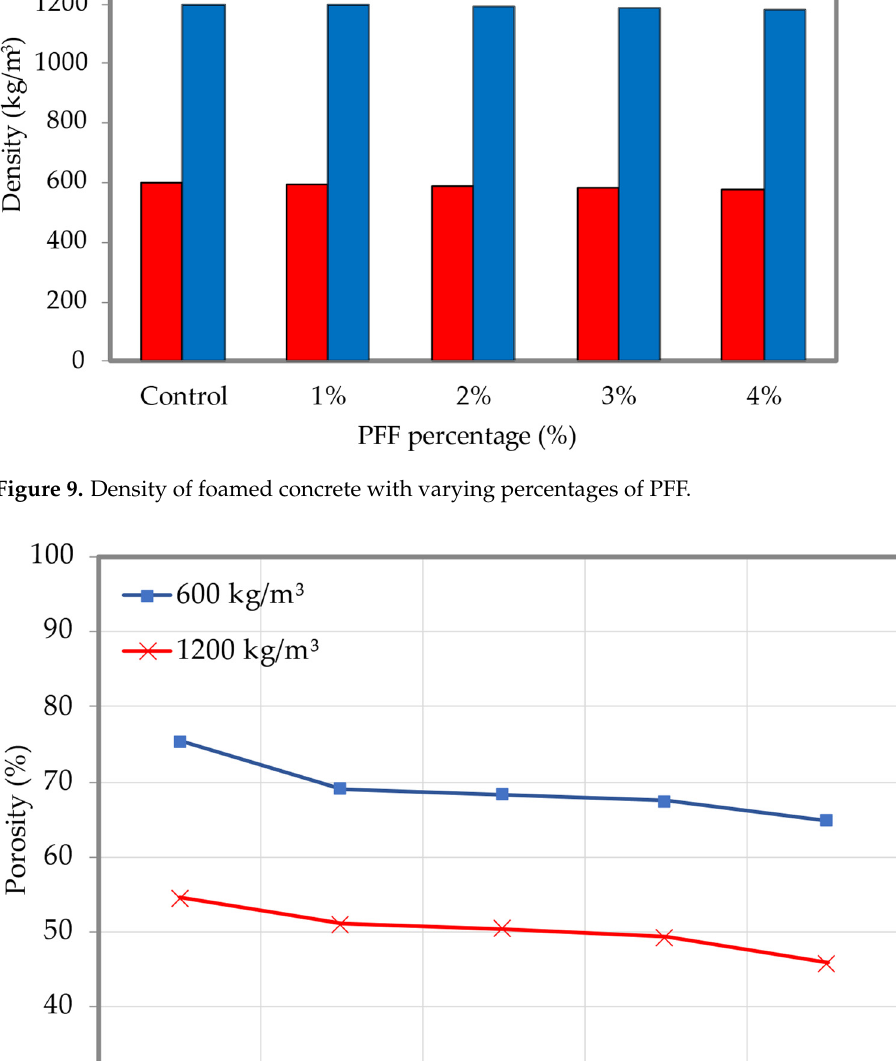
( b ) Figure 11. Morphology of ( a ) control specimen; ( b ) foamed concrete with 4% PFF. 4.4. Water Absorption The findings of foamed concrete’s water absorption with various PFF percentages are shown in Figure 12 (the dataset can be found in Appendix A, Table A2). It was clear that as PFF percentages increased from 1% to 4%, the foamed concrete’s ability to absorb water increased as well. For both densities examined in this study, the inclusion of 4% of PFF resulted in the highest water absorption. It should be noted that less cracking occurs in foamed concrete when PFF is added to the mix, and the cracks that do form are smaller and finer than they are in foamed concrete without PFF. This suggests that the presence of PFF can significantly increase foamed concrete’s capacity to absorb water and signifi- cantly reduce the risk of microcrack merging [32]. Ramezanianpour et al. [33] explored the impact of polypropylene fiber percentages ranging from 0.5% to 4.0% on concrete wa- ter permeability. They discovered that adding polypropylene fiber decreased the extent of concrete water penetration. The effect of multi-size polypropylene fibers on the imper- meability of concrete was analyzed by Guo et al. [34]. They discovered that, whereas coarse fibers had more obvious macropore inhibition effects on concrete, small fibers had